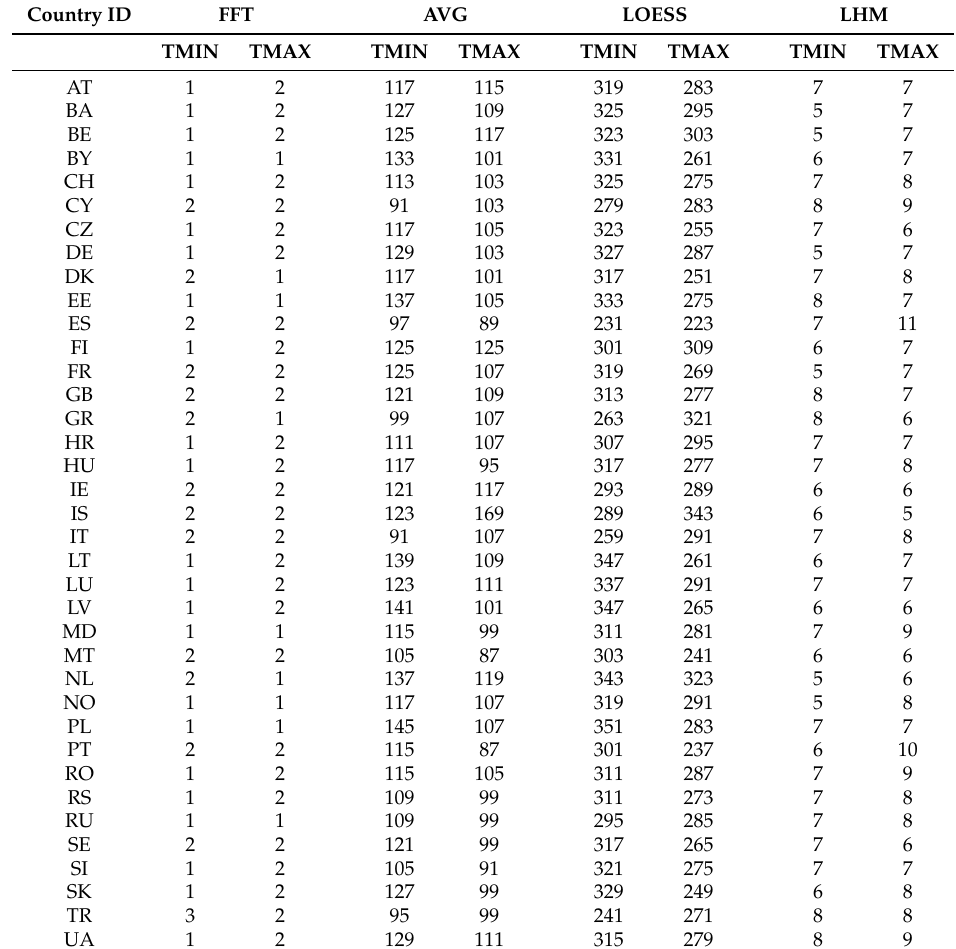
Table A4. Complexity selected for each country and method, and for minimum and maximum temperatures. From left to right: number of harmonics for the FFT, window size for AVG and LOESS, and number of knots for the